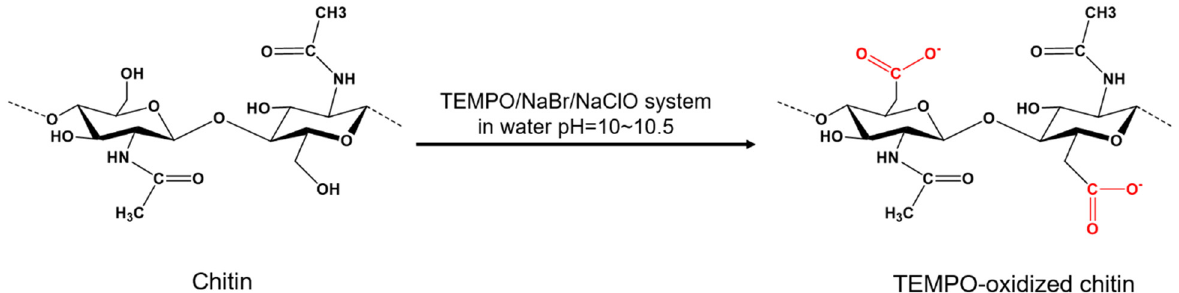
Figure 34: Reaction scheme of chemical pretreatment of chitin to introduce carboxylate groups into the surface of chitin via the TEMPO - mediated oxidation